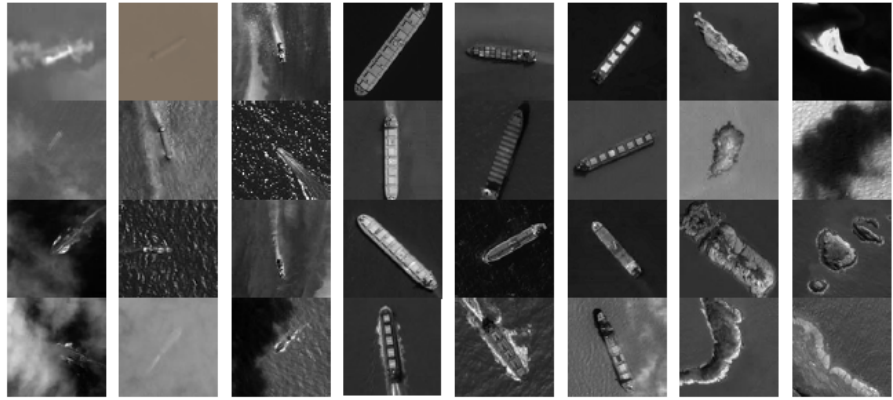
Figure 5. The presentation of positive and negative sample datasets. Among them, the scenes of positive samples in the first three columns are cloud interference, low contrast, and complex sea conditions; Columns 4–6 are positive samples in the normal sea background; and the last two columns are negative